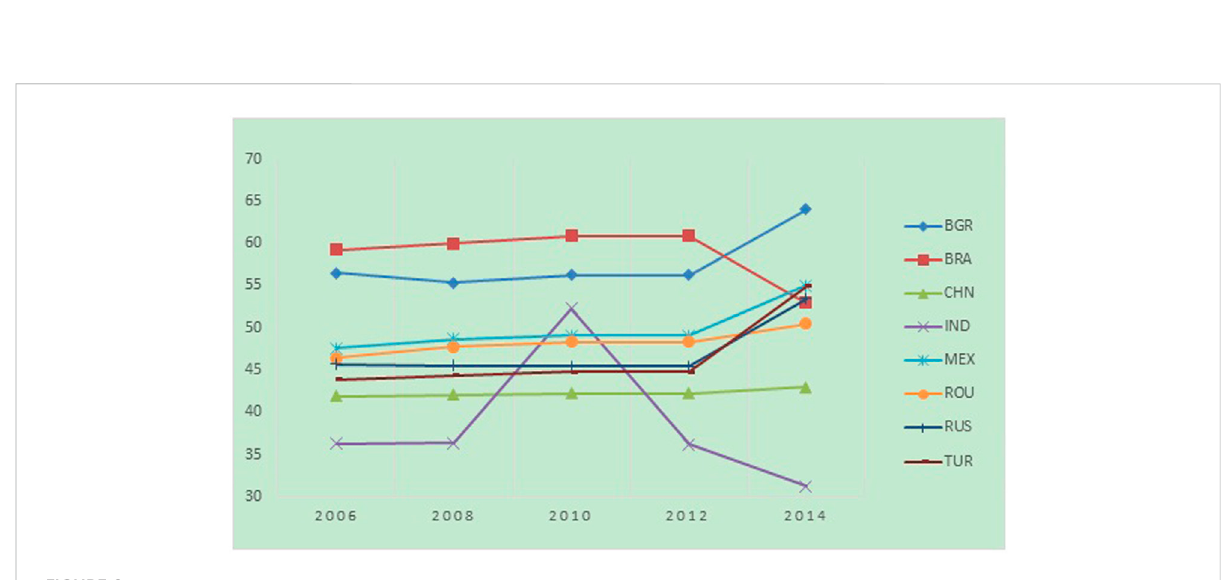
FIGURE 2 Trend of the EPI in middle-income